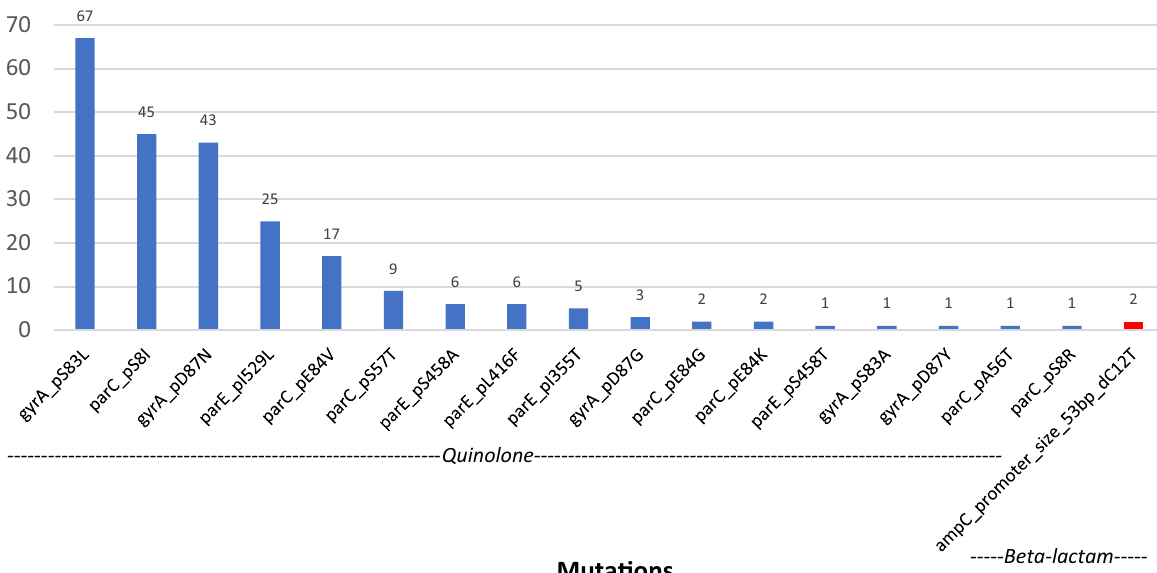
Figure 2. Identified mutational resistance based on mutations with a known phenotype from 234 E. coli isolates from bloodstream infections between 1985 and 2018. Mutations in the gyrA and parC genes can result in (fluoro) quinolone resistance (blue), mutations in ampC-promotor genes can results in beta-lactam resistance (red). Mutations responsible for resistance to the 11 tested antibiotics are summarized in the Supplementary Data